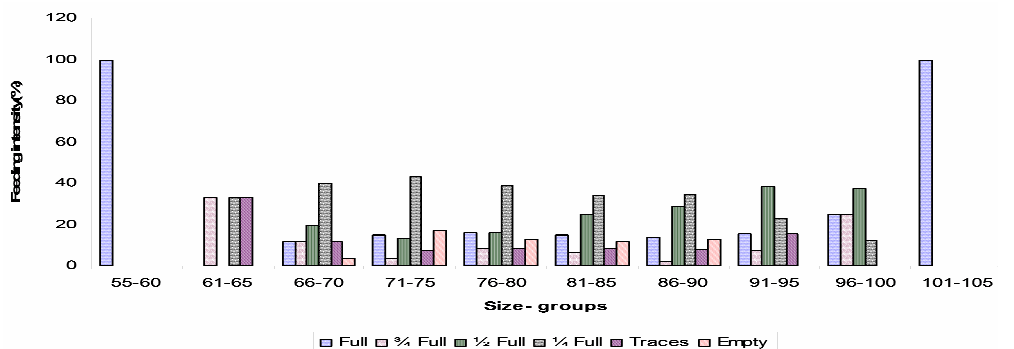
Fig. 9. Month-wise feeding intensity in females of S. melantho